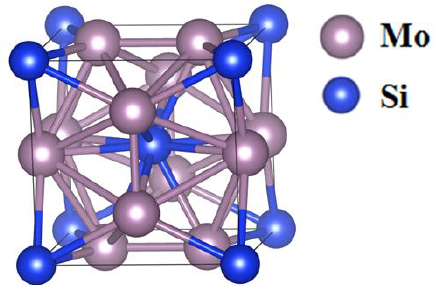
Figure 1. Crystal structure of Mo 3 Si.